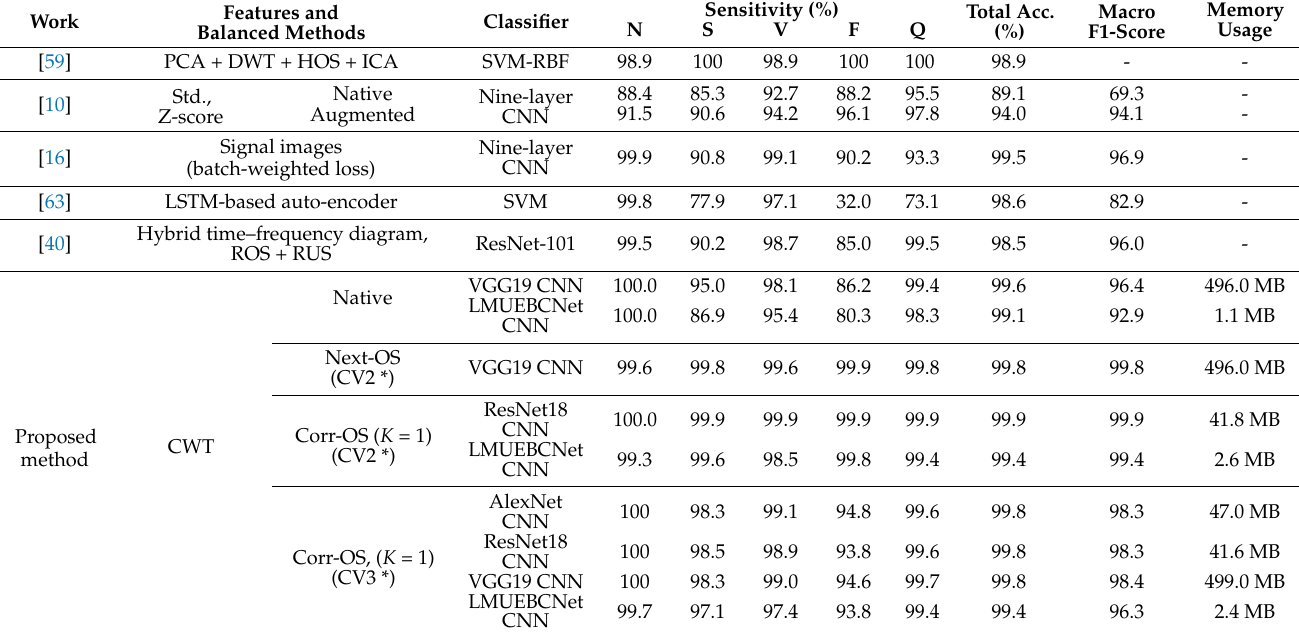
Table 6. Comparison with the existing literature (10-fold